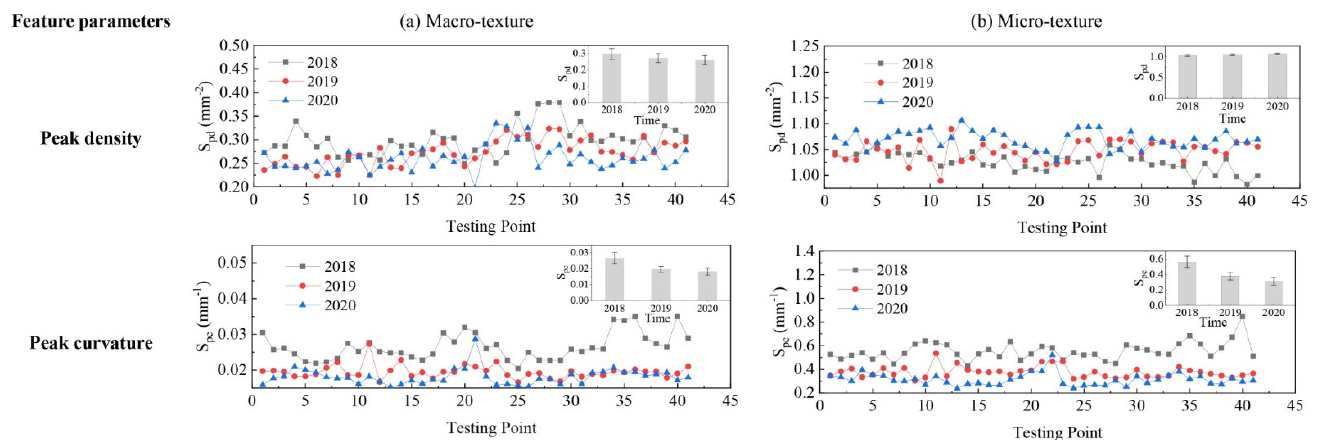
Figure 14. Pavement texture variations via feature parameters: ( a ) Macro − texture, and ( b ) Micro − texture.